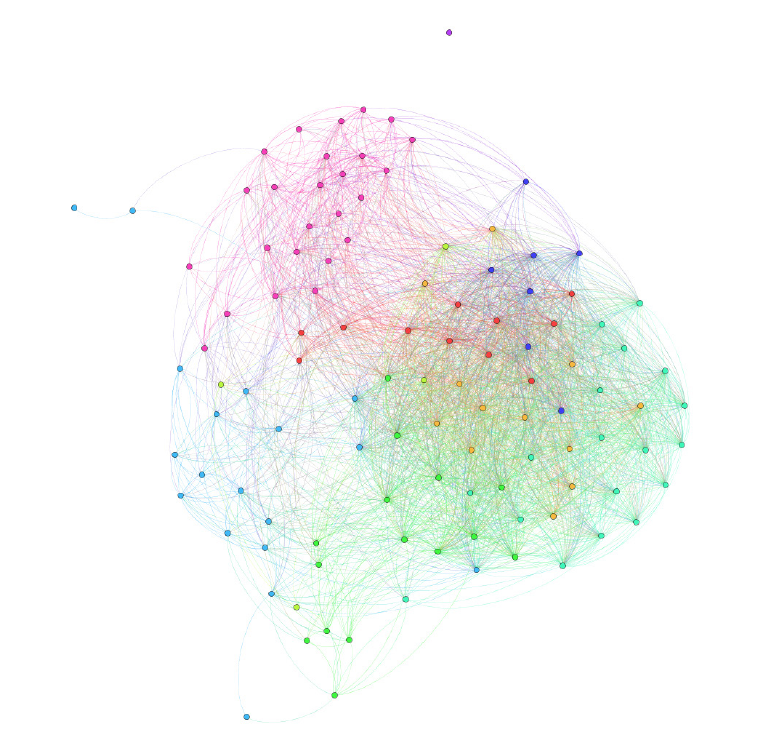
Figure 14. Communities in the network detected using a resolution of